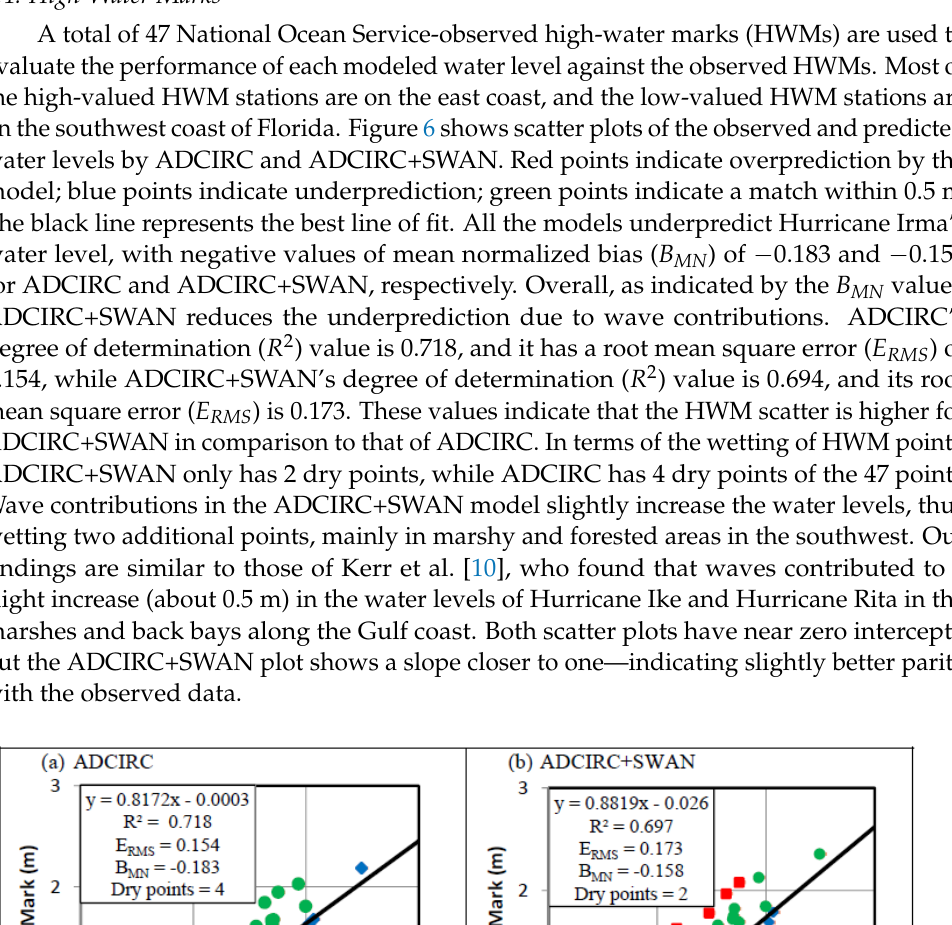
Figure 5. Observed and modeled significant wave height (m) (left column), and average wave pe- riod (s) (right column) time series (2017) for Hurricane Irma at selected stations using ADCIRC + SWAN: ( a , e ) St. Augustine, ( b , f ) Pulley Ridge, ( c , g )Fernandina Beach, and ( d , h ) Port Canaveral.